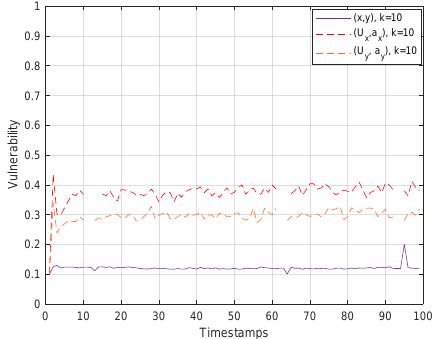
Figure 12. Vulnerability Performance Comparison in Euclidean and Hough- X